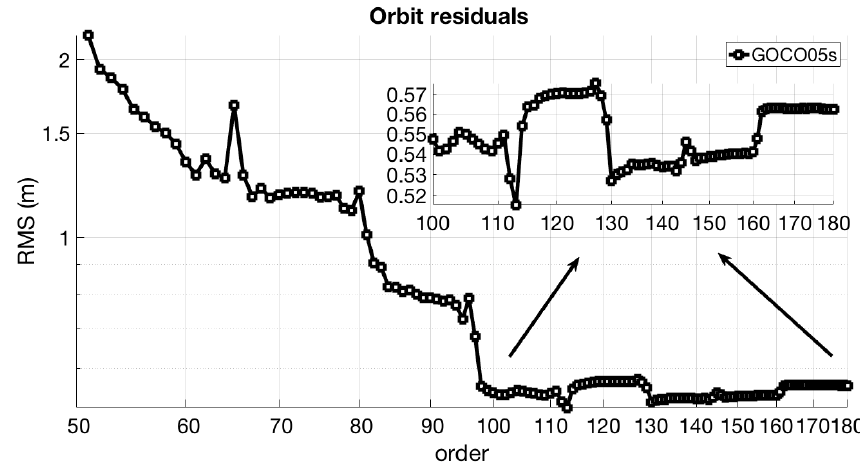
Figure 6. RMS variances of GOCE orbit residuals with respect to the order of the spherical harmonic